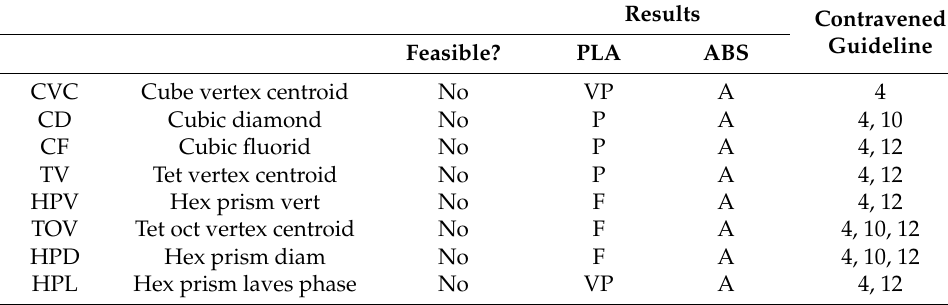
Table 5. Results of 3D printing tests of lattice structures for both PLA and ABS, scale 1:1.